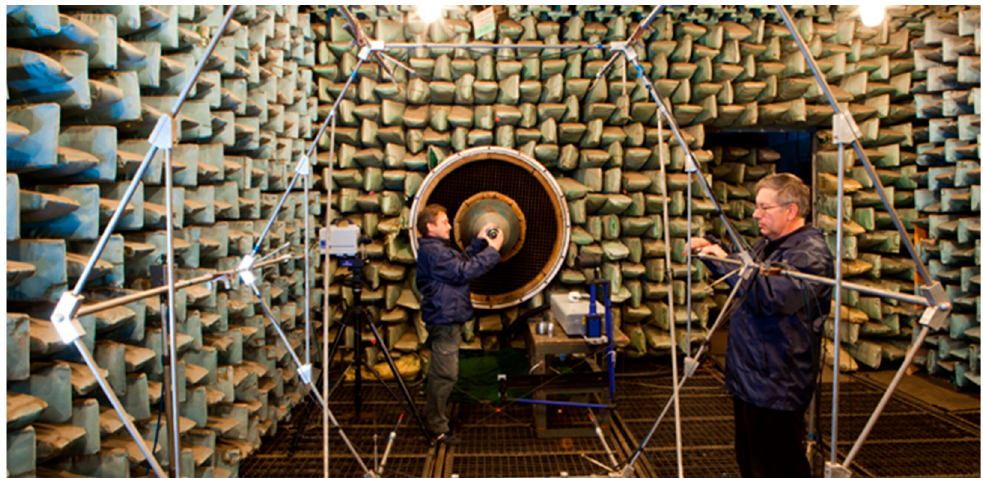
Figure 1. A photo of anechoic facility AC-2 TsAGI.